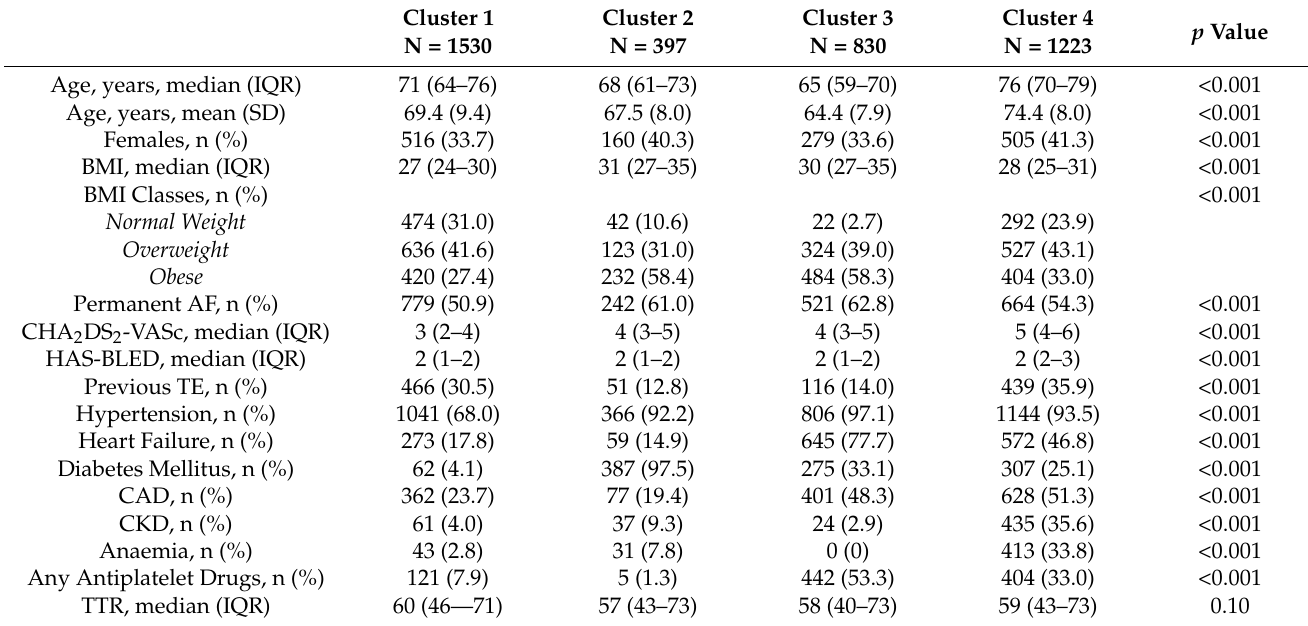
Figure 1. Dendrogram generated by hierarchical clustering process showing the four AF clusters. The dendrogram graph is the visual representation of the hierarchical clustering process. Vertical lines are clusters that are joined together and the position of the line on the scale indicates the distance at which clusters were joined (the greater the difference in height, the more dissimilarity exists between clusters). The red line indicates the stopping location. Table 1. Baseline characteristics of patients stratified by